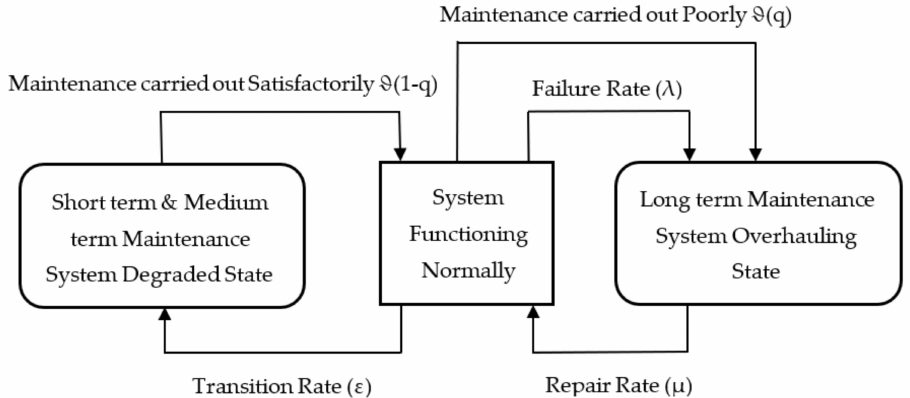
Figure 4. Transition diagram for a curing machine model with its states and action of RL. λ —Failure rate = 1/MTTF. µ —Repair rate = NR/TMT. ε —Transition rate. ϑ —Maintenance rate.